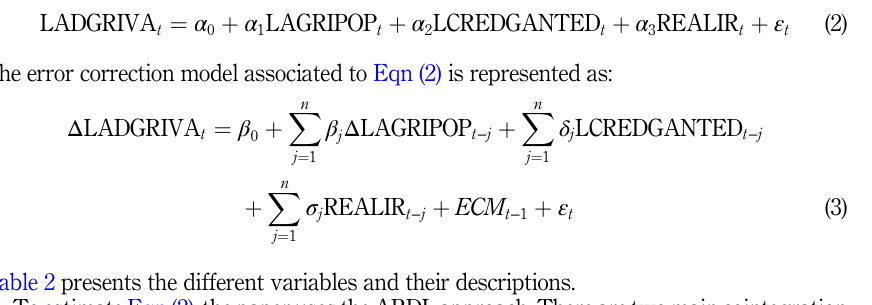
Table 2 presents the different variables and their